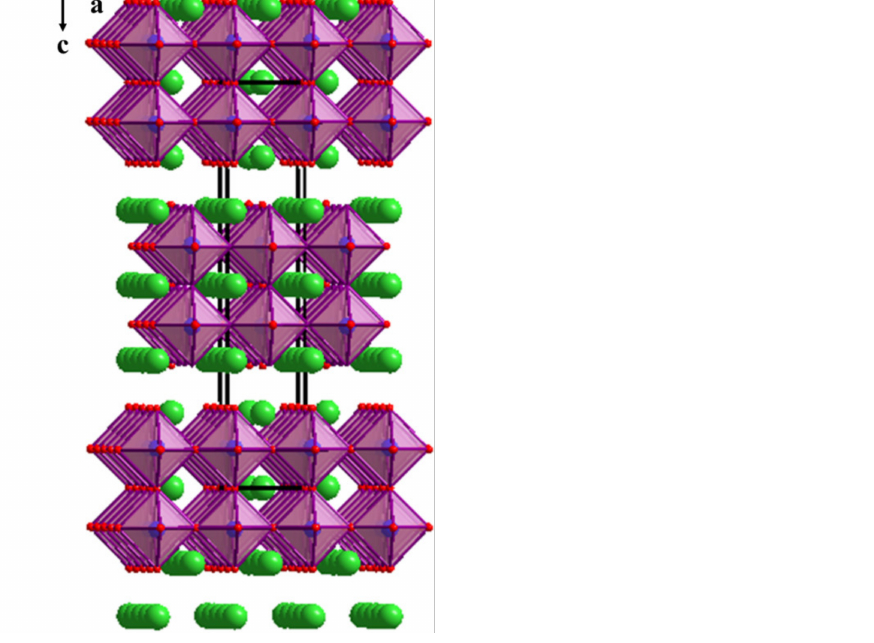
Figure 1. Crystal structure of Sr 3 TiMO 7 (M = Ti, Mn, Fe, Co). Green spheres represent La, and red spheres show oxygens. The BO 6 octahedra are shown purple in